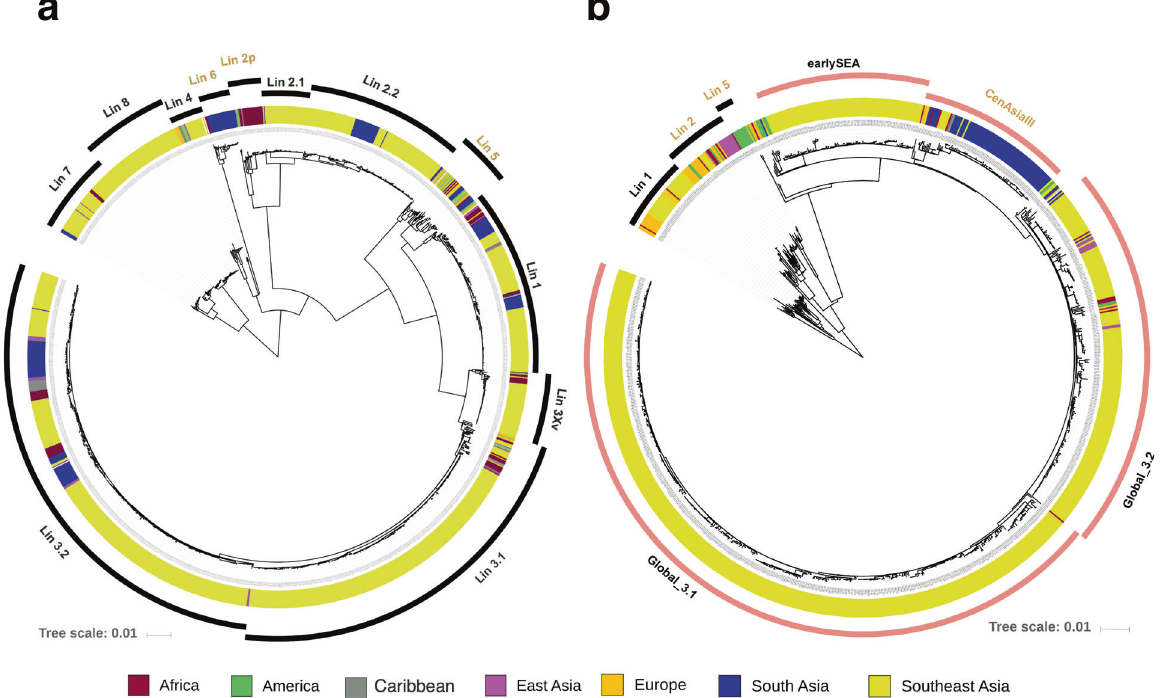
Fig. 2 The global phylogenetic structure of Shigella fl exneri and Shigella sonnei . a The maximum likelihood phylogeny of 1323 S. fl exneri isolates, compiled from those sequenced for this study and a previously published study on S. fl exneri global diversity (ref. 10 ). Different lineages were identi fi ed based on Bayesian Analysis of Population Structure hierarchical clustering (hierBAPS) and were named in accordance to the nomenclatures de fi ned in ref. 10 (Lineages 1 – 7), with Lineage 8 newly de fi ned in this study. The tree is rooted using Lineages 7 and 8 (see Methods). b The maximum likelihood phylogeny of 993 S. sonnei isolates, compiled from those sequenced for this study and previously published studies on S. sonnei global diversity (ref. 8 ), S. sonnei local evolution in Vietnam (ref. 9 ), and S. sonnei local evolution in Bhutan (ref. 34 ). The isolates are grouped into lineages de fi ned previously in the global diversity study (ref. 8 ), and the tree is rooted using Lineage 1. For both ( a ) and ( b ), the colours of the inner ring indicate the isolate ’ s geographical source (see key) while the outer ring de fi nes the lineage clustering (with S. sonnei Lineage 3 ’ s sub-lineages coloured in pink). Lineages that do not contain substantial numbers of Southeast Asian sequences are labelled in orange and excluded from downstream analyses. The horizontal scale bar shows the number of nucleotide substitutions per site.